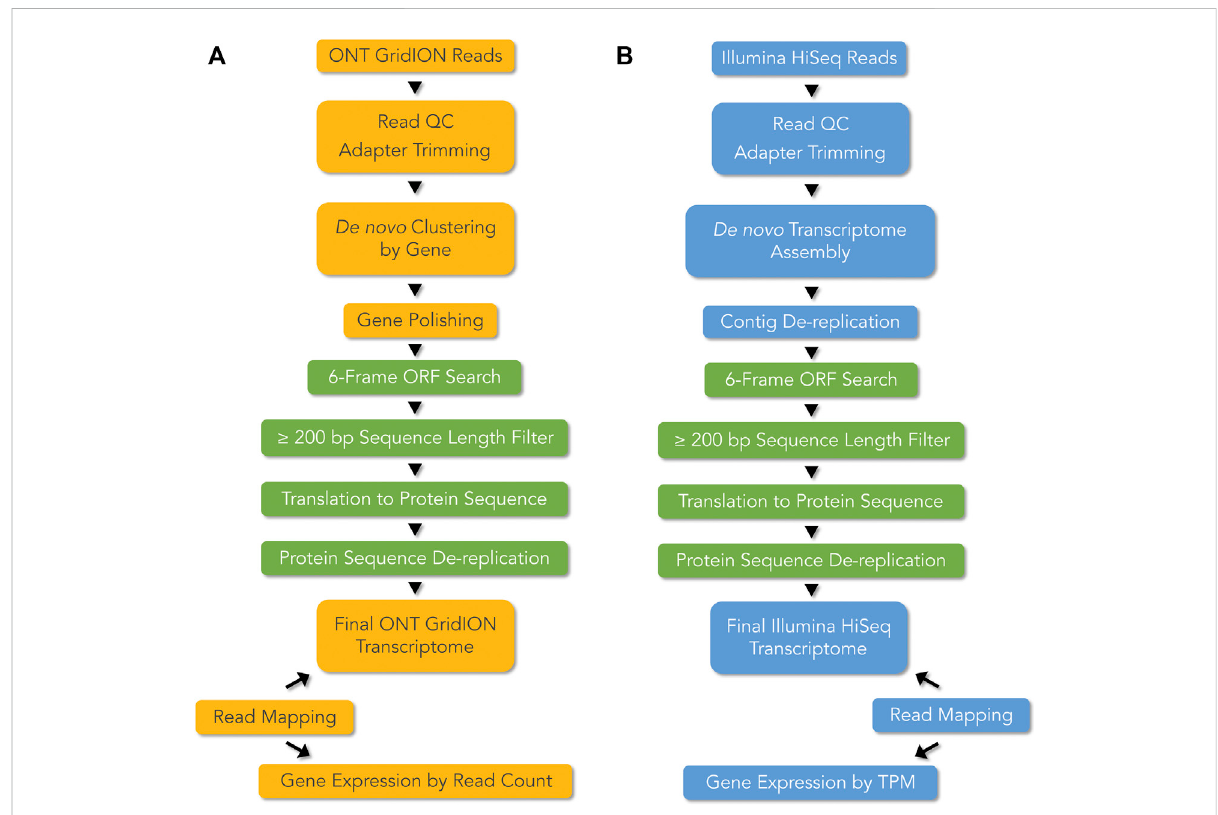
FIGURE 2 Denovo transcriptomepipelinesfor (A) ONTlong-read technology, and (B) Illuminashort-readtechnology.mRNAfromtheaccessoryglandsof Sepsis punctum ,wasusedforcDNAlibrarypreparationandRNAsequsingONTlong-readandIlluminashort-readtechnologies.ONTtranscriptsweregeneratedby de novo gene clustering, consensus generation, and gene polishing, whereas for Illumina short-reads were de novo assembled to reconstruct contigs. Preliminarytranscriptomeswere fi lteredusingcommonsteps(showningreen),usingsix-frameOpenReadingFrame(ORF)searches, ≥ 200bplength, anddereplicationat100%proteinidentity,toderive fi naltranscriptomes.Geneexpressionwasquanti fi edusingreadcountasaproxyforONTandTranscript per Million (TPM) for